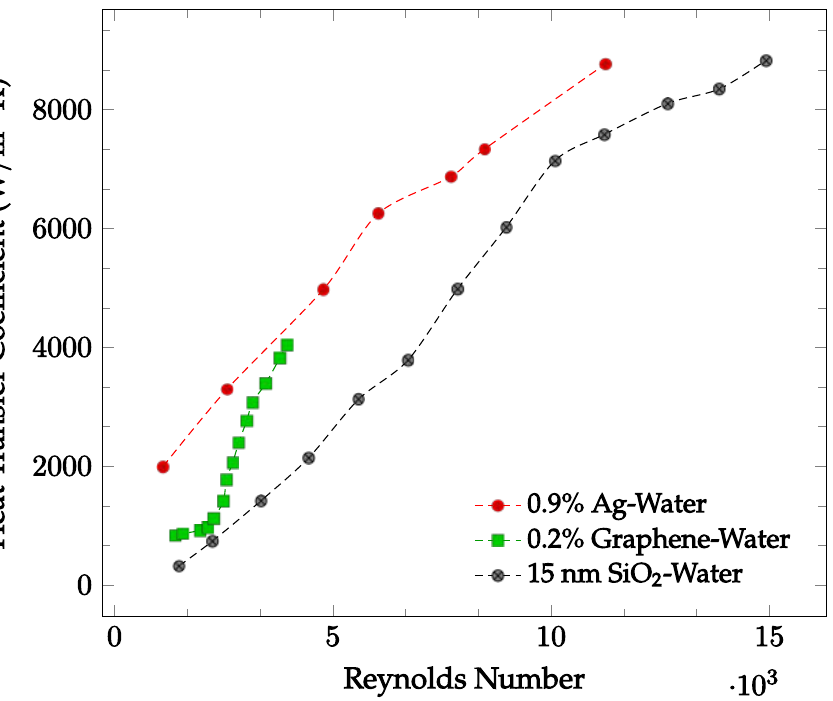
Figure 5. Convective heat transfer coefficient with respect to Reynolds Number over the laminar and turbulent flow regimes for various water-based nanofluids: 0.9% Ag at 48 °C [43], 0.2% Graphene with constant heat flux [5], 15 nm SiO 2 [44].